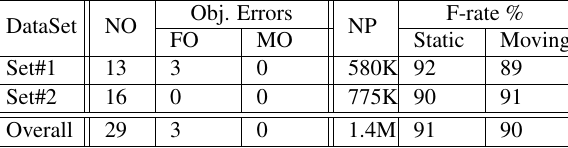
Table 2: Numerical evaluation of the detection results obtained by the proposed object level analysis. Number of real Objects (NO), Missing Objects (MO), False Objects (FO), Number of Points (NP) and pixel level F-rates (in %) are listed for each data set, also and in aggregate.